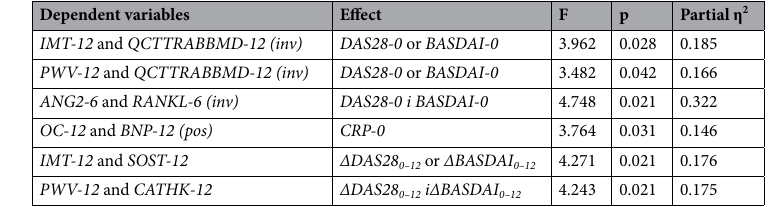
Table 5. Significant results of general linear model (GLM) multivariate analysis of variance (MANOVA) test determining the effects of an independent variable on the association of two dependent variables. ANG2 angiopoietin 2, BASDAI Bath ankylosing spondylitis disease activity index, BNP B-type natriuretic peptide, CRP C-reactive protein, DAS28 28-joint disease activity score, GLM general linear model, IMT carotid intima-media thickness, inv inverse, OC osteocalcin, MANOVA multivariate analysis of variance, pos positive, PWV pulse- wave velocity, QCTTRABBMD QCT trabecular bone mineral density, RANKL receptor activator nuclear κB.